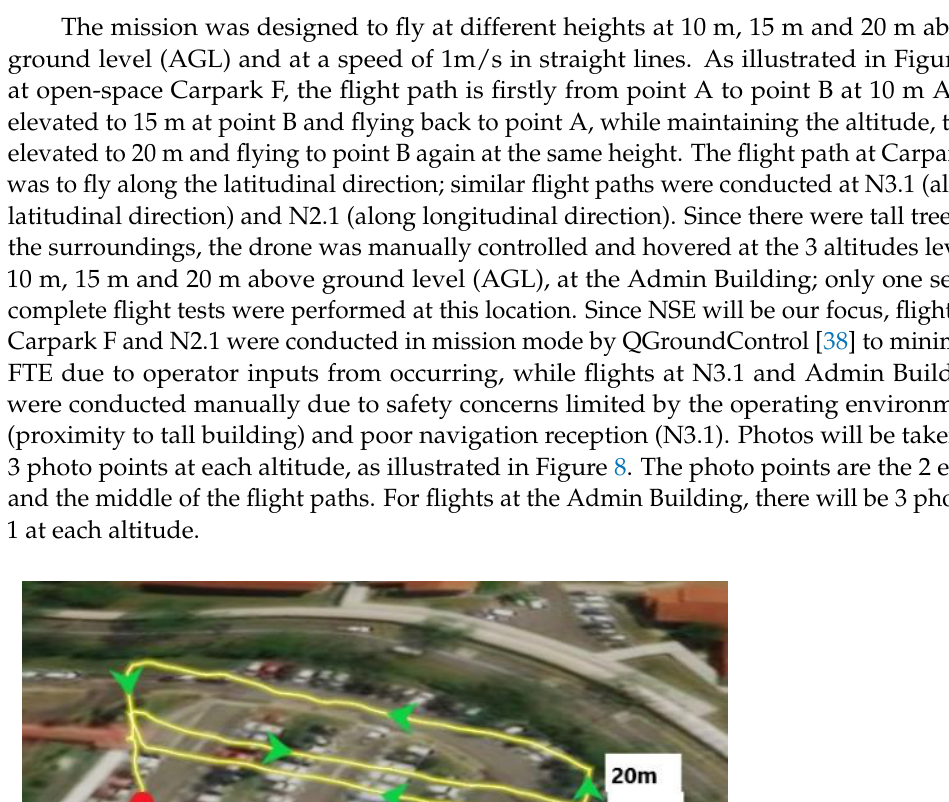
Figure 6. Experiment Setup.